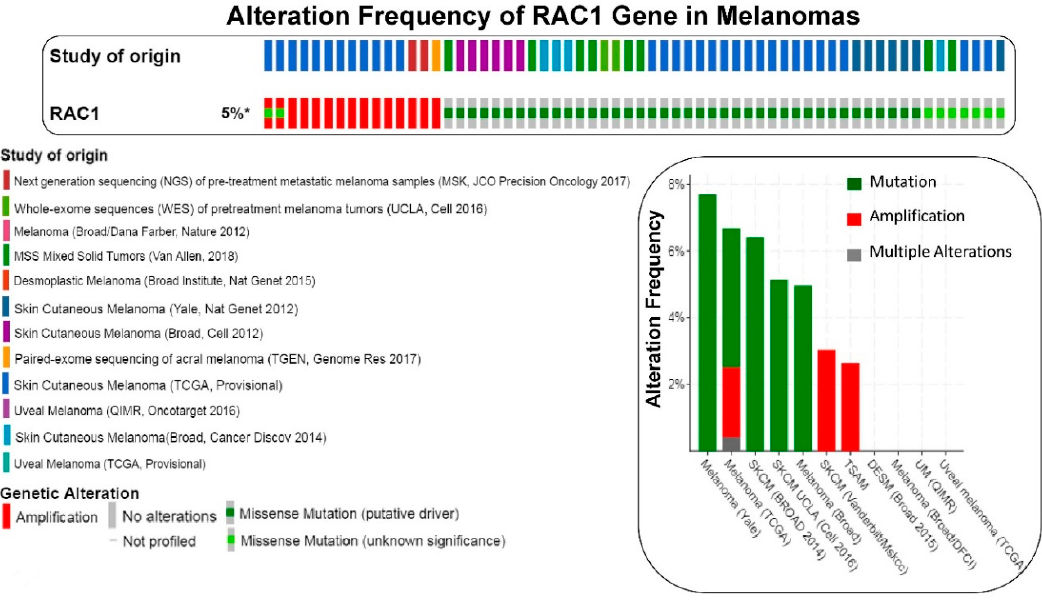
Figure 2. The frequency of alteration of RAC1 gene in melanomas: The oncoprint presents data obtained from c-BioPortal (February 2019) representing a combined study of 1315 samples (http://www.cbioportal.org), querying 1273 patients/1315 samples in 12 studies, as shown in the different color codes of the oncoprint (upper panel) under “Study of origin” in the figure. The percentage (5%*) represents the alteration of the RAC1 gene in patients with melanomas. The lower panel of the oncoprint represents the types of alterations of RAC1 gene in samples as shown under “Genetic Alteration” in the figure. Unaltered cases (RAC1 gene) were not included in the oncoprint. The bar diagram (figure on the right panel) represents the frequency of alterations in RAC1 gene in a few individual melanoma studies where alterations were identified. The Y-axis of the bar diagram represents the alteration frequency of the RAC1 gene (colors represent the types of alterations as shown in the figure). The frequencies of the alterations are sorted on the X-axis according to “Cancer Study”. MSS Mixed Solid Tumors (Van Allen, 2018) is not represented in the bar-diagram.